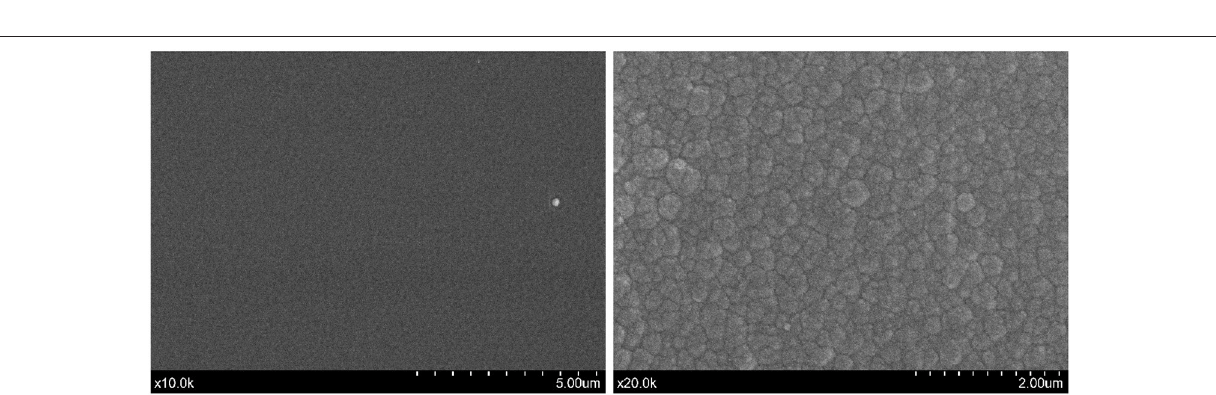
that p -values for the paired t -test for are larger than 0.05. This means that there is no significant difference in roughness parameters between AFM1 and AFM2 columns of the table (the AFM measurements of the samples before and after the